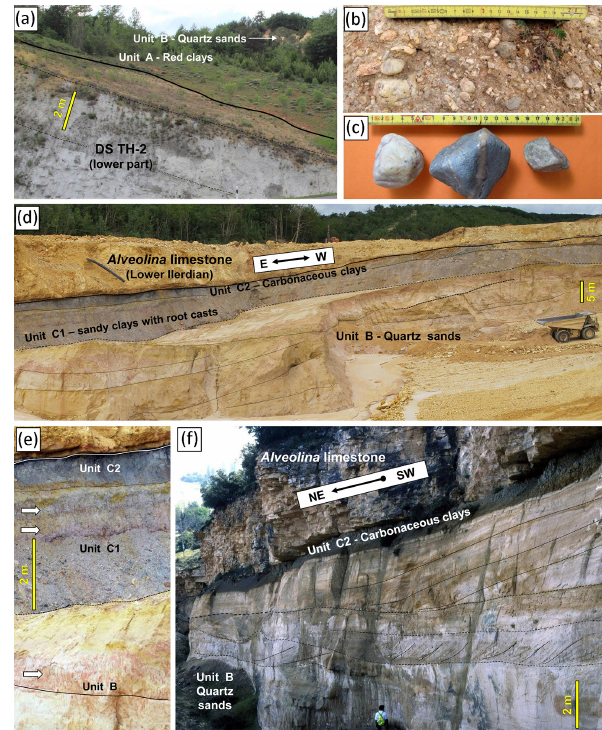
Figure 6. Incised valley deposits. Panel (a) : abandoned quarry to the north of Birgara: general view of terrestrial unit A abruptly overlying upper Thanetian sandy marls and limestones of DS TH-2. Panel (b) : close-up of a pebble-rich part of unit B. Panel (c) : exam- ples of subrounded pebbles of unit B with flattened facets sugges- tive of ventifacts. Panel (d) : general view of terrestrial units B and C, and of the overlying Alveolina limestone, in the active front of the Laminoria quarry. Note concave-up internal erosional surfaces in unit B (quartz sands). The dumper is about 6.5m high. Panel (e) : close-up of a part of the Laminoria quarry front, the white ar- rows indicating horizons with hematite-coated root casts. Panel (f) : terrestrial units B and C in the Villalain Quarry; note large-scale unidirectional cross-bedding in unit